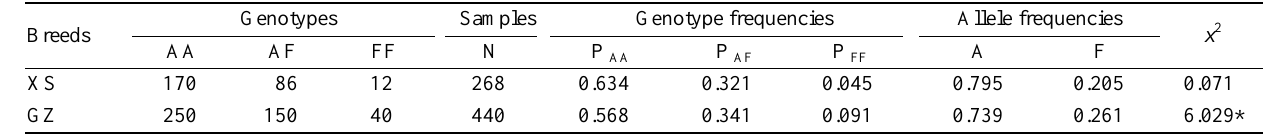
Table 2. Genotype and allelic frequencies of CSN1S2 gene in 2 dairy goat breeds Breeds